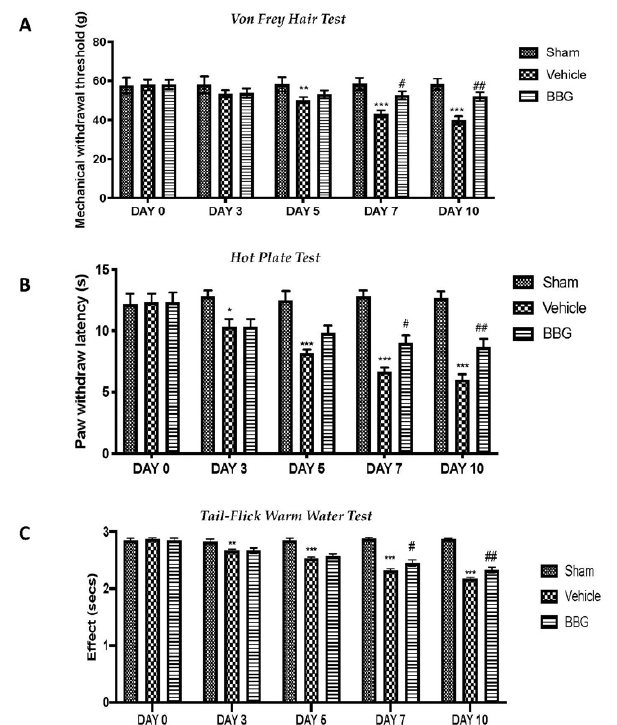
Figure 5. Behavioral analysis: von Frey hair test ( A ), hot plate test ( B ) and tail-flick warm water test ( C ). Data are representative of at least three independent experiments and are expressed as mean ± SEM from N = 6 rats/group. * p < 0.05 vs. sham; ** p < 0.01 vs. sham; *** p < 0.001 vs. sham; # p < 0.05 vs. vehicle; ## p < 0.01 vs. vehicle.